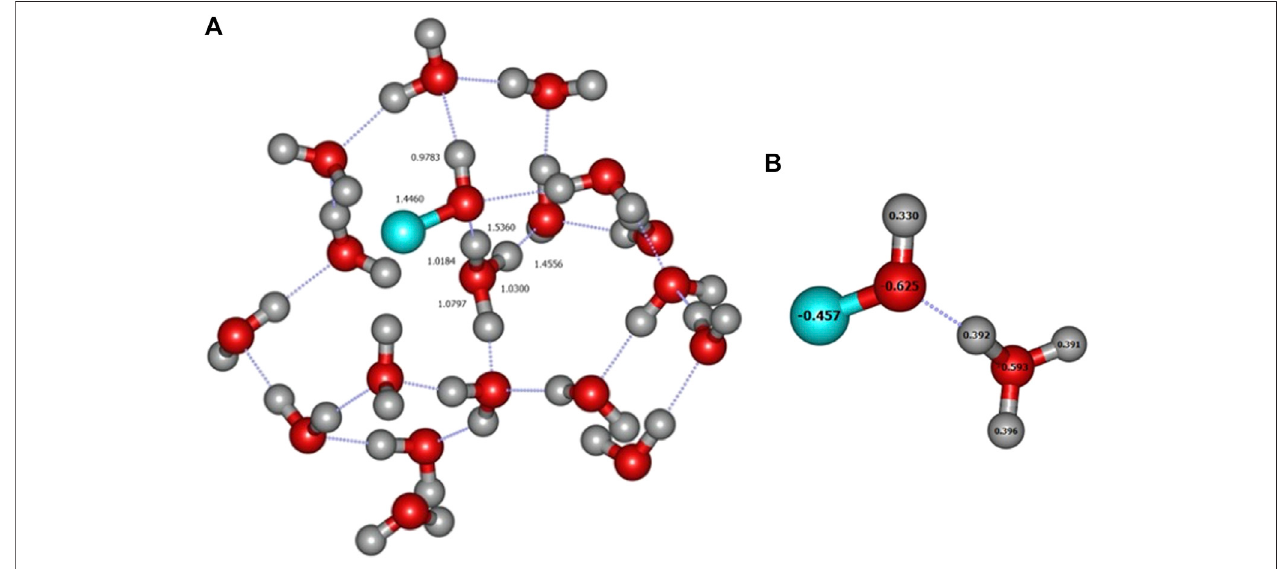
FIGURE10|(A) FormationoftheH 3 O + COH − complexinanamorphousenvironment.DistancesaregiveninAngströms. (B) NBOchargesfromONIOM( ω B97X-D/ 6-31+G**:PM6) calculation.